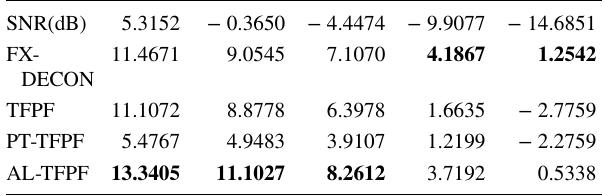
Fig. 12 a Amplitude spectrum of 25-Hz synthetic signal. b Amplitude spectrum of 35-Hz synthetic signal. c Amplitude spectrum of 45-Hz syn- thetic signal Table 1 Amplitude loss with different methods